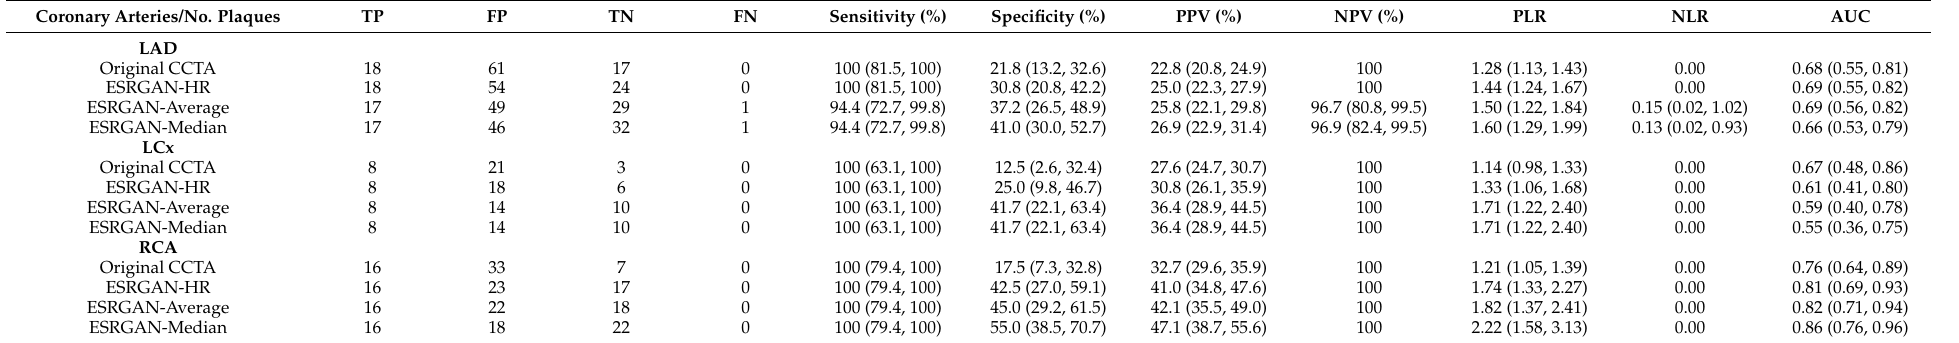
Numbers in the bracket indicate 95% confidence interval. AUC-area under the receiver operating characteristic curve; FN-false negative; FP-false positive; HR-high-resolution; LAD-left anterior descending artery; LCx-left circumflex artery; NLR-negative likelihood ratio; NPV-negative predictive value; No.-number; PLR-positive likelihood ratio; PPV-positive predictive value; RCA-right coronary artery; TN-true negative; TP-true